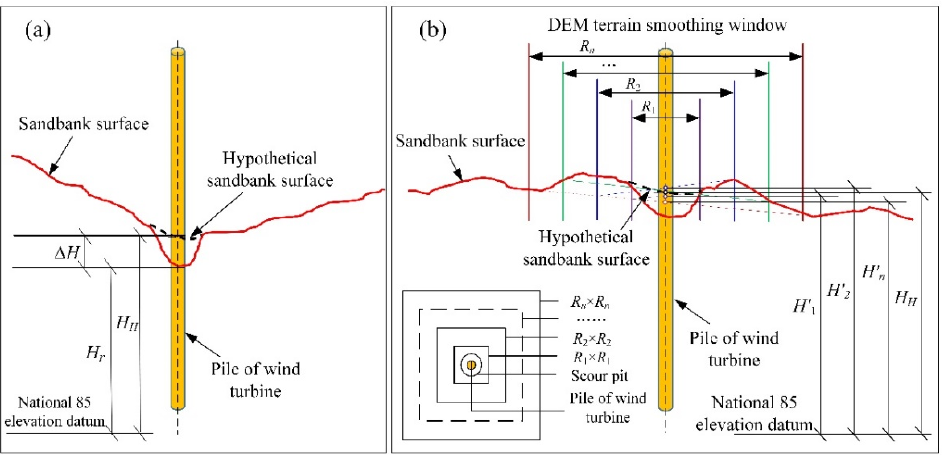
Figure 4. The schematic diagram for the HSSDM. ( a ) Topographic change height ( ∆ H ) calculation for the area around the wind turbine. ( b ) Estimation of H H from the average heights of a series of smoothing windows of different sizes.